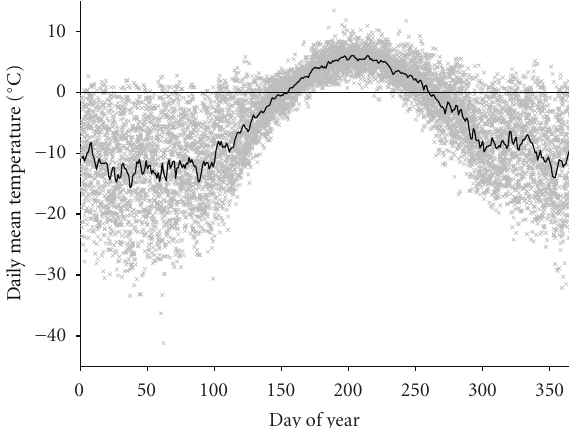
Figure 1: Daily mean temperature at Ny- ˚Alesund. Solid line indicates the average for each day over the period 13.9.1982 till